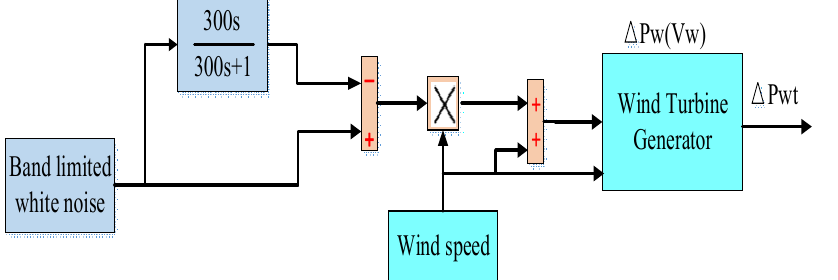
Figure 3. The wind power modeling using MATLAB/Simulink [44].